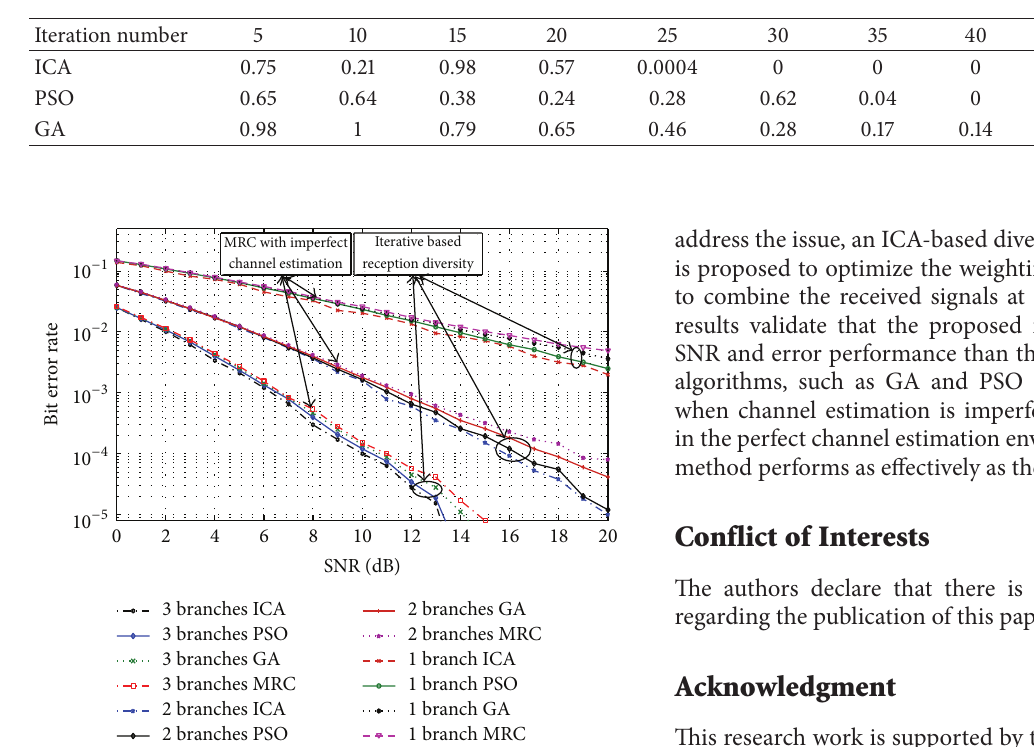
Table 4: Variance of SNR of all algorithms when the population size is 25.